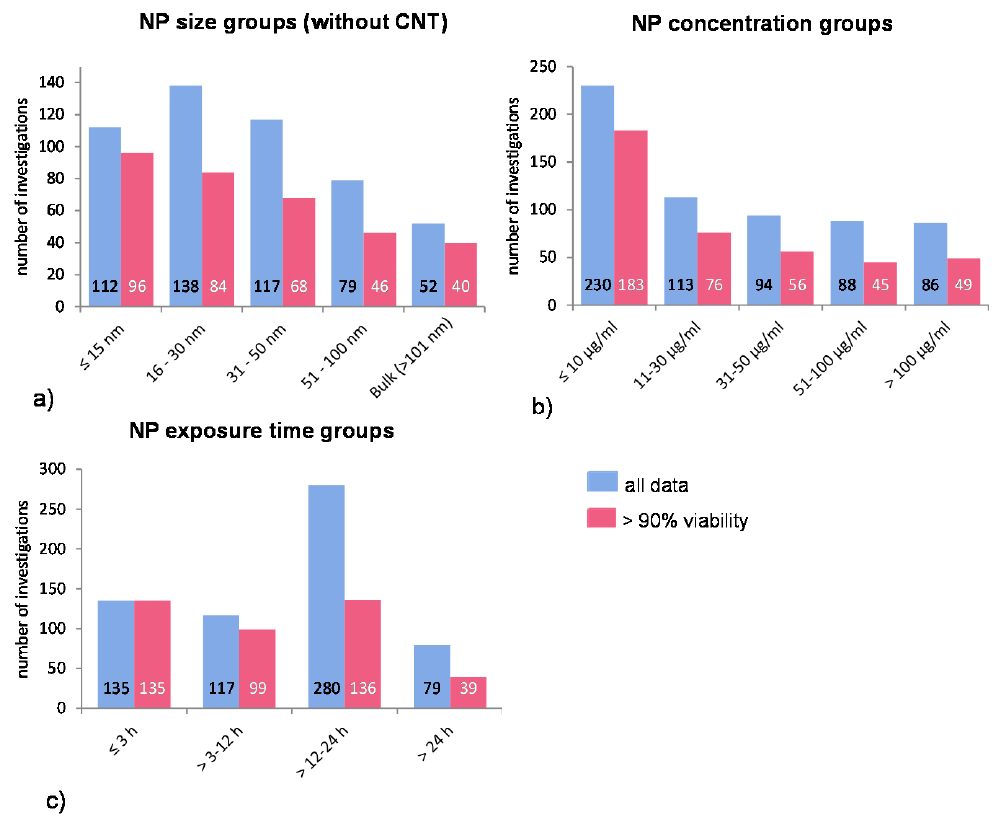
Figure 1. Distribution of all investigations according to NP ( a ) size- (without CNT data); ( b ) concentration-; and ( c ) exposure time groups. The blue bars represent the mean ROS ratios of all data, and the red bars the ROS ratios of cells with more than 90% viability. Data are illustrated as mean, and numbers inside the bars represent the number of investigations.